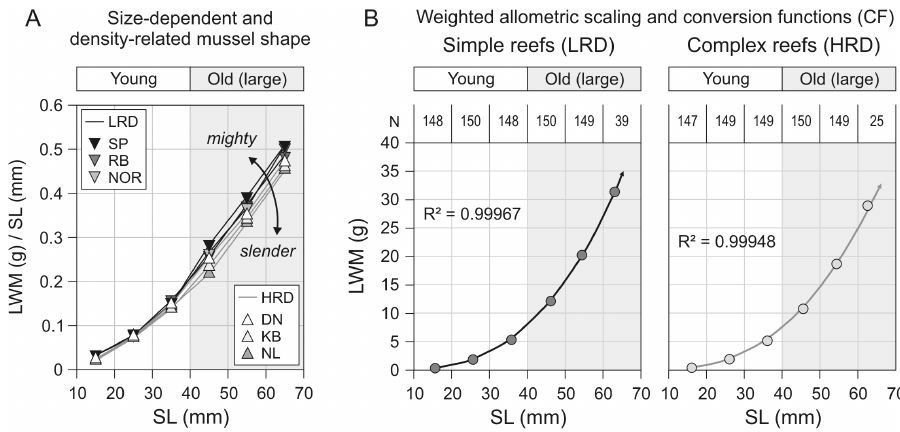
Figure 8. Mussel shape and allometric scaling. A Size-dependent (young/old) and density-related (LRD, HRD) mussel shape. Plotted is individual LWM (g) per SL (mm) against SL (mm) of 6 SL classes per site. B Determination of LWM weighted CF. Plotted is LWM (g) against SL (mm) of 6 SL classes after pooling individual metrics from 2008 through 2012 according to reef type. Given are powered relationships and coefficients of determination (R²). Old (large) mussels highlighted (gray area). Number of mussels per SL class is given (N). Scaling parameters of all weighted CF are listed in Table